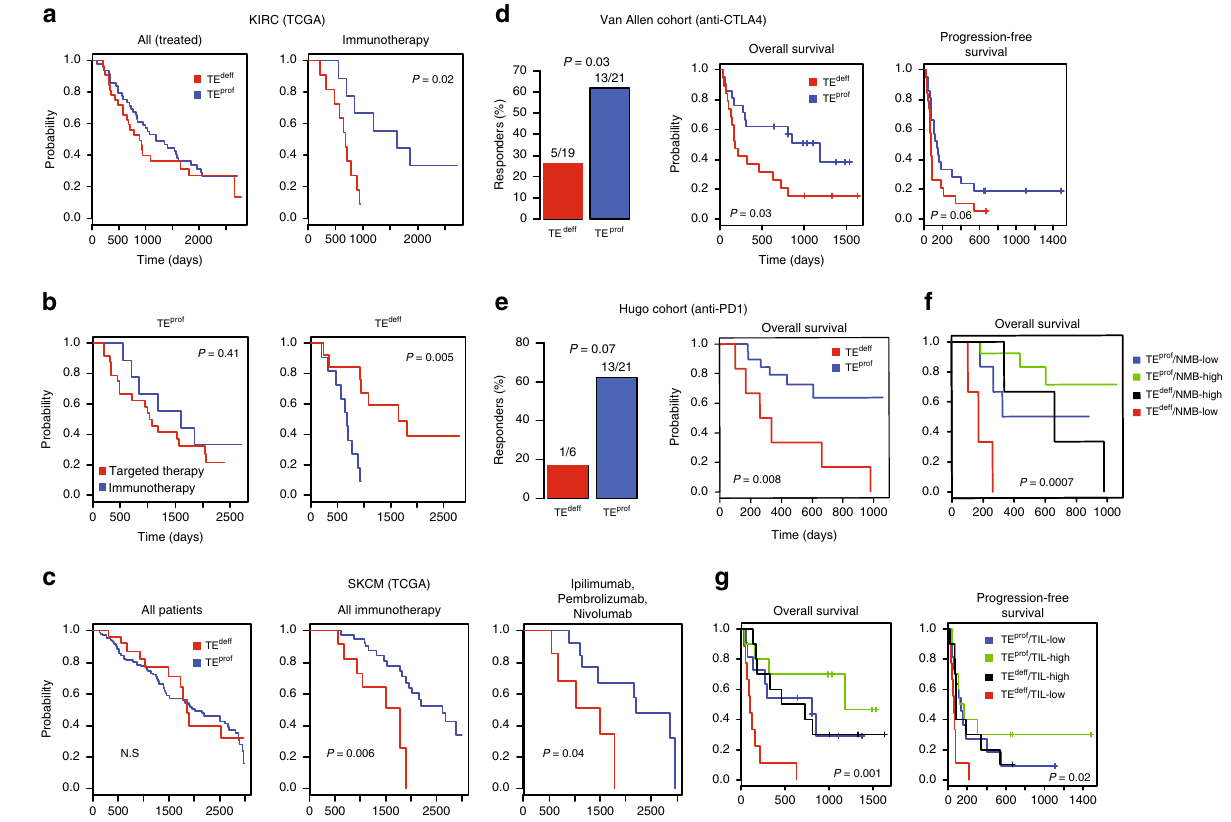
Fig. 4 TE deff correlates with clinical resistance to immunotherapy. a Kaplan – Meier survival curves of TE deff and TE prof KIRC patients. Left: all patients with treatment data, right: those that received immunotherapy (IL2 and IFN), b Kaplan – Meier survival curves of TE prof and TE deff patients treated with immunotherapy or targeted therapy. c Same as in a in SKCM patients. Middle: patients treated with immunotherapy other than immune checkpoint inhibitors, right: patients that received immune checkpoint inhibitor therapy. d Left: percentage of therapy responders among TE deff and TE prof subset of the Van Allen et al cohort, right: progression-free and overall survival curves of TE deff and TE prof samples in this cohort, e Left: percentage of responders among TE deff and TE prof subset in the Hugo et al. cohort, right: Kaplan – Meier curves for OS in TE deff and TE prof patients, f overall survival curves of patients in the Hugo cohort strati fi ed based on TE deff and the non-synonymous mutational burden (NMB), g Kaplan – Meier curves of OS and PFS in the Van Allen cohort strati fi ed according to TE deff and TIL status. The p -values in survival analyses re fl ect Wald test, and in the barplots Fisher ’ s exact